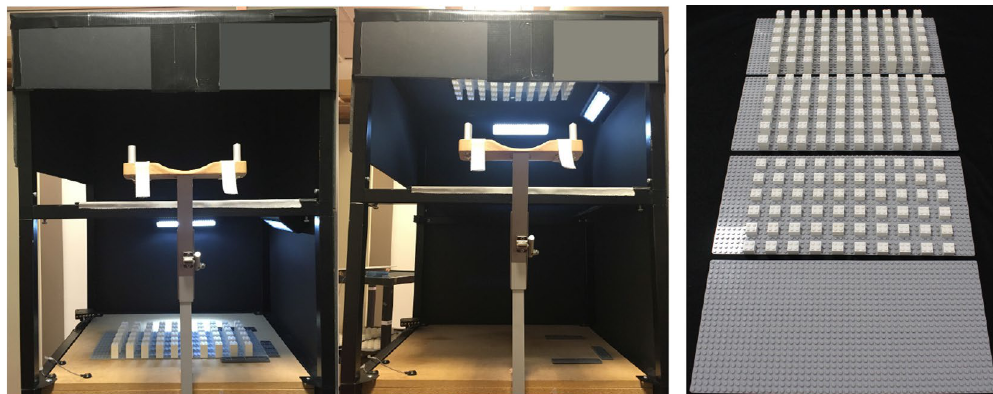
Figure 2. Setup and stimuli. Mirror setup with obstacle placement in the real condition (left) and obstacle placement in the mirror condition (middle). The mirror located in the centre of the box projects the obstacles